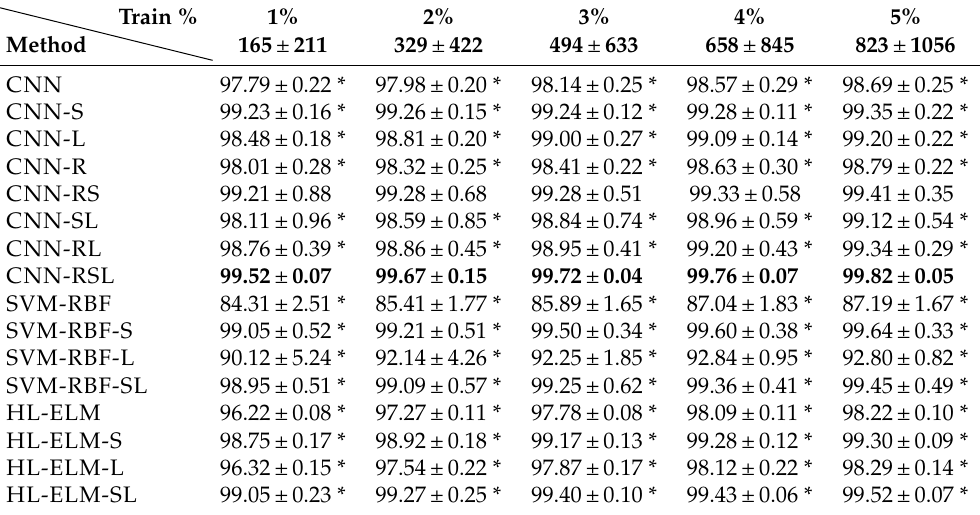
Table 3. Test set classification accuracy on the Pavia Center dataset, when using 1–5% randomly sampled labeled pixels per class for training. We report the mean and standard deviation over 10 runs. We also list the mean and standard deviation of the number of training pixels per class for each training %. The best accuracy for each training set is indicated in bold. An ‘*’ means that the best accuracy is significantly better than the accuracy achieved by the corresponding method according to a binomial test for comparing classifiers [45] ( p -value < 0.05).